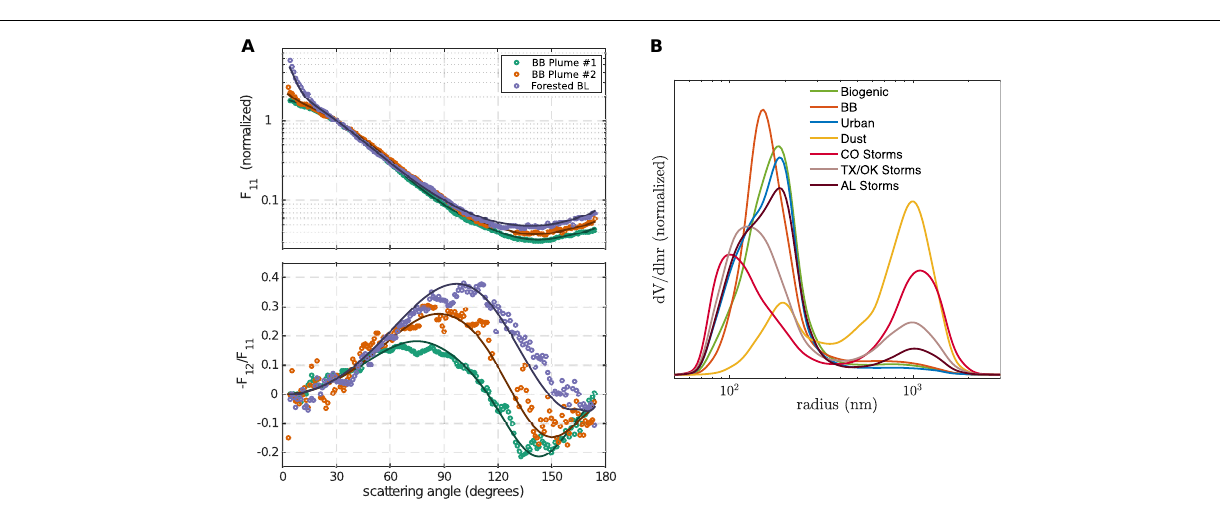
FIGURE 10 | (A) Measured phase function ( F 11 ) in upper panel and degree of linear polarization (– F 12 / F 11 ) in lower panel for three different samples encountered during the SEAC4RS campaign in North America in 2013. The samples include two different biomass burning plumes (BB plume) and a pass through a forest boundary layer heavy in biogenic aerosol (Forested BL). Shown are direct measurements from the UMBC PI-Neph, taken from Figure 5 in Espinosa et al. (2017). (B) Retrieved particle volume size distributions using the GRASP (Dubovik et al., 2014) retrieval software with PI-Neph inputs similar to those shown in the top panel. Different aerosol types after Espinosa et al. (2018) are shown. Data were collected during the DC3 (2012) and SEAC4RS (2013) field